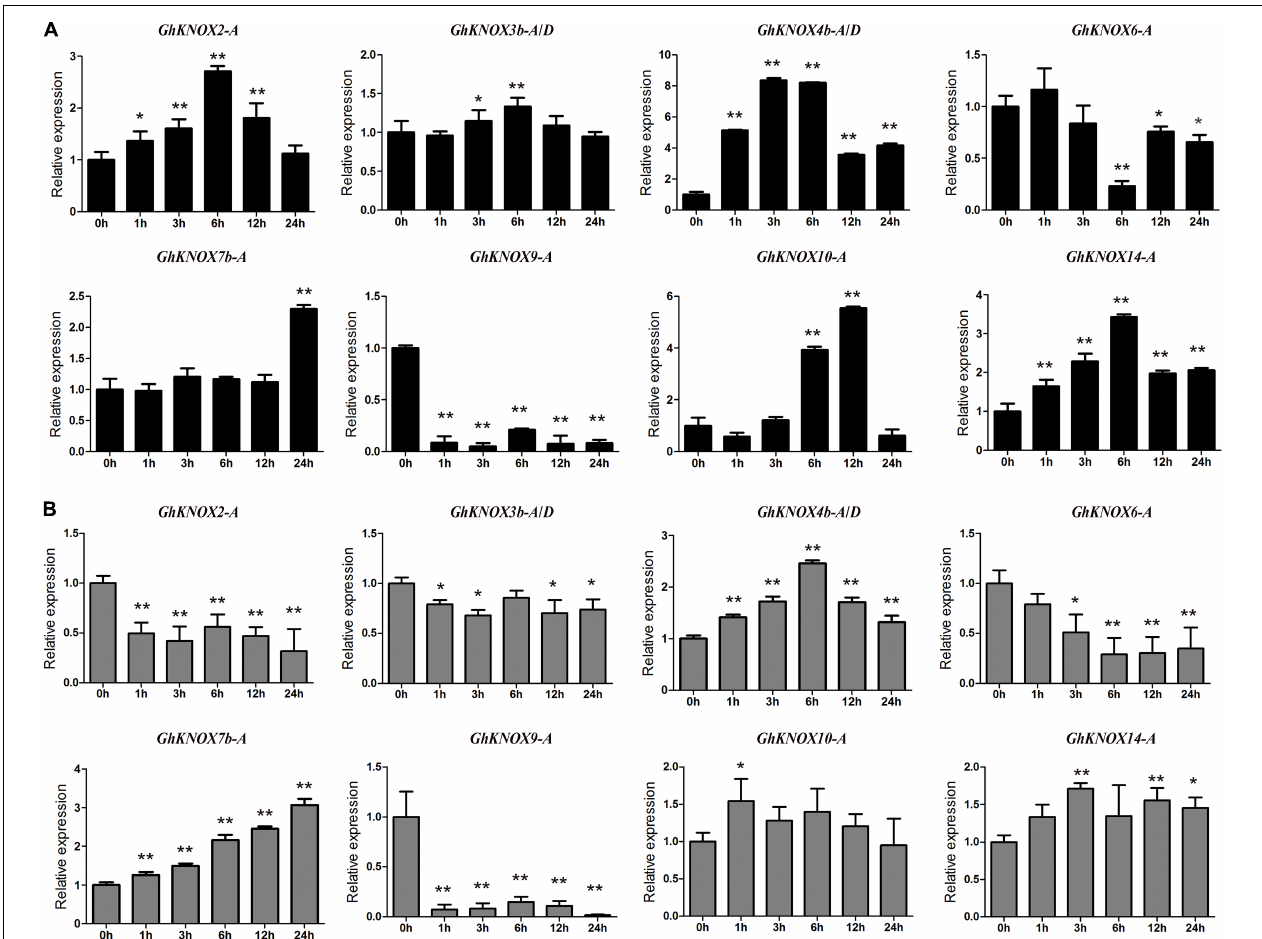
FIGURE 7 | Expression patterns of selected GhKNOX genes in response to PEG or NaCl stress treatment. (A) Relative expression levels of GhKNOX genes between the control (0 h) and different time points (1, 3, 6, 12, and 24 h) under 20% PEG treatments. (B) Relative expression levels of GhKNOX genes between the control (0 h) and different time points (1, 3, 6, 12, and 24 h) under 200 mM NaCl treatment. GhACTIN (AY305733) was used as an internal control. Error bars indicate the standard deviation of three independent experiments. Relative expression was calculated using the 2 − (cid:77)(cid:77) Ct method. The significance of differences between means was determined using analysis of variance (* P < 0.05, ** P <